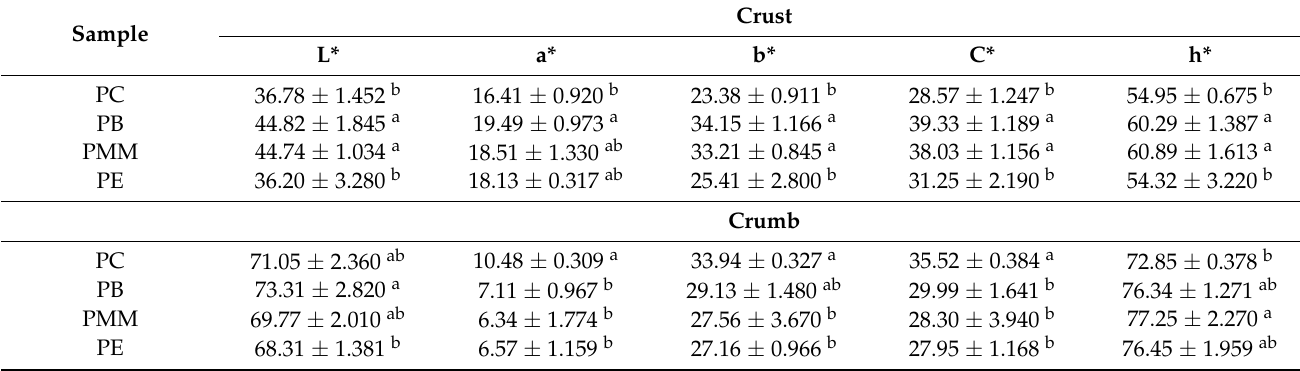
Table 3. Color of the crumb and crust of panettone.